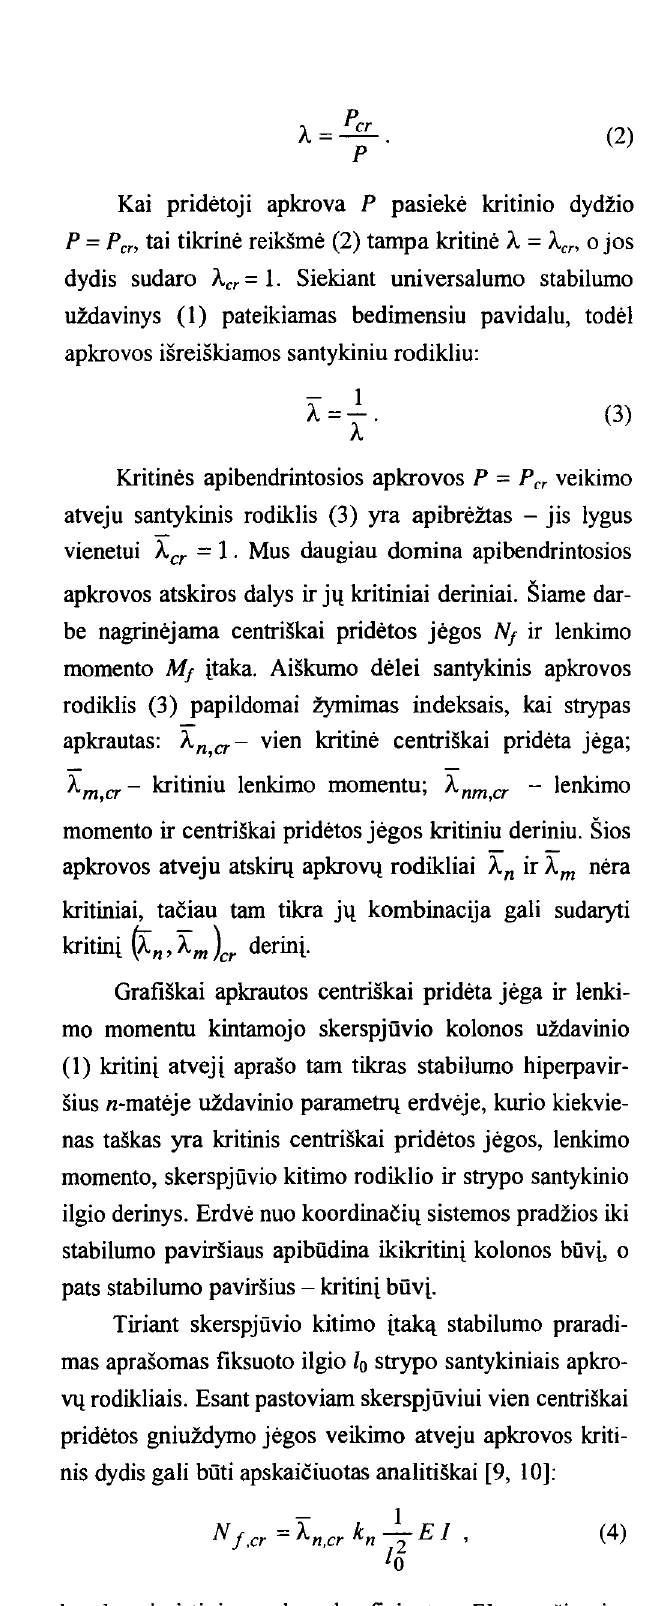
Fig 1. Thin-walled beam element with 14 degrees of free dom: u - linear displacement; cp - rotation; e - warping displacement